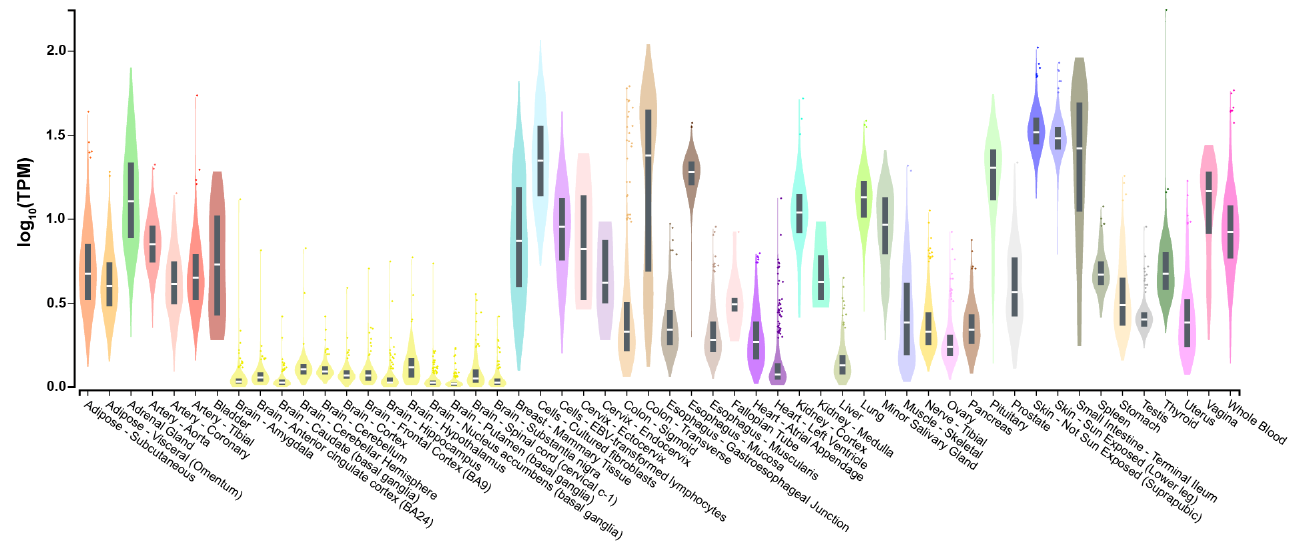
Figure 1. Expression of the VDR gene in 54 different human tissues. Normalized RNA sequencing (RNA-seq) data are shown in TPM (transcripts per million), where all isoforms were collapsed into a single gene. Box plots display the median as well as 25th and 75th percentiles. Points indicate outliers that are 1.5 times above or below interquartile range. Data are based on GTEx analysis release V8 (dbGaP Accession phs000424.v8.p2) [30].